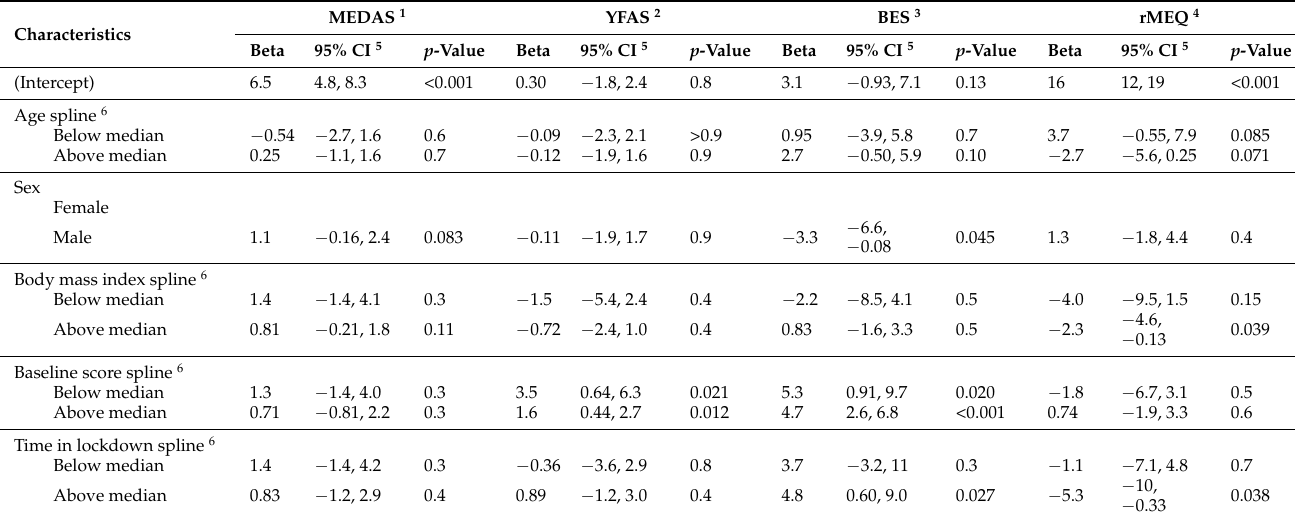
Table 5. Coefficients of linear models for questionnaire continuous scores at follow-up. For each model, the outcome was the continuous scores of the questionnaire used to evaluate the secondary endpoints and predictors time in lockdown, baseline score, age, sex, and baseline body mass index.